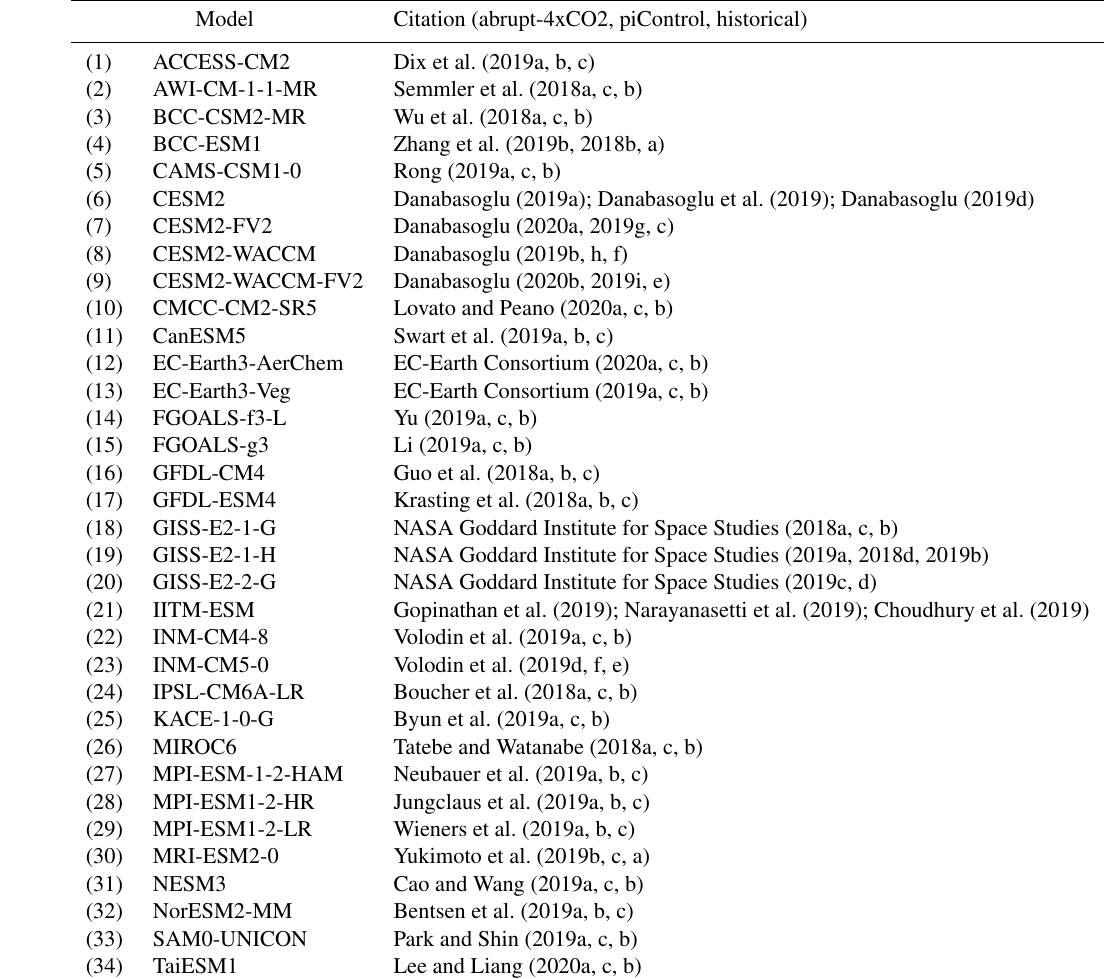
Table 1. CMIP6 member models used in this study and their representative numbers when model number is displayed in figures. Model Citation (abrupt-4xCO2, piControl,